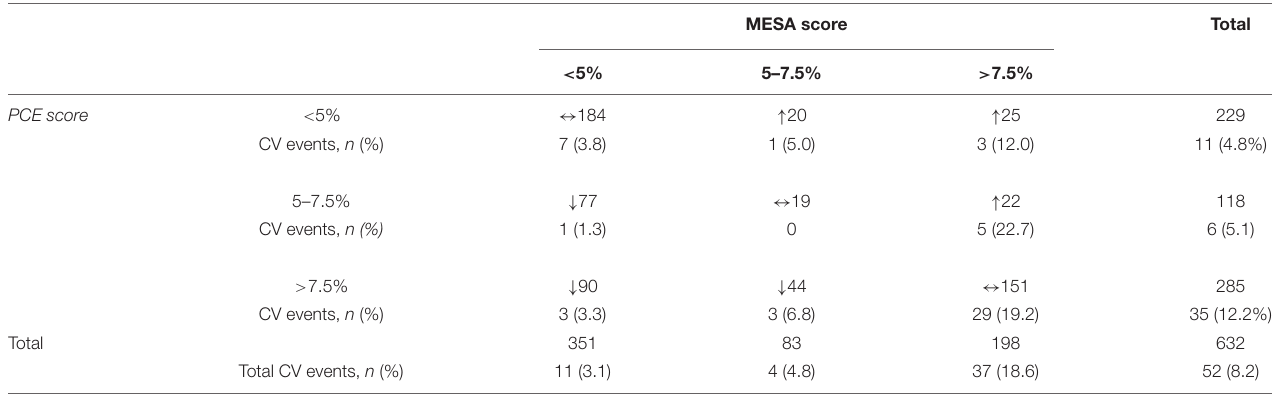
TABLE 2 | Paired comparisons of MESA and PCE categories for cardiovascular disease, including stroke.